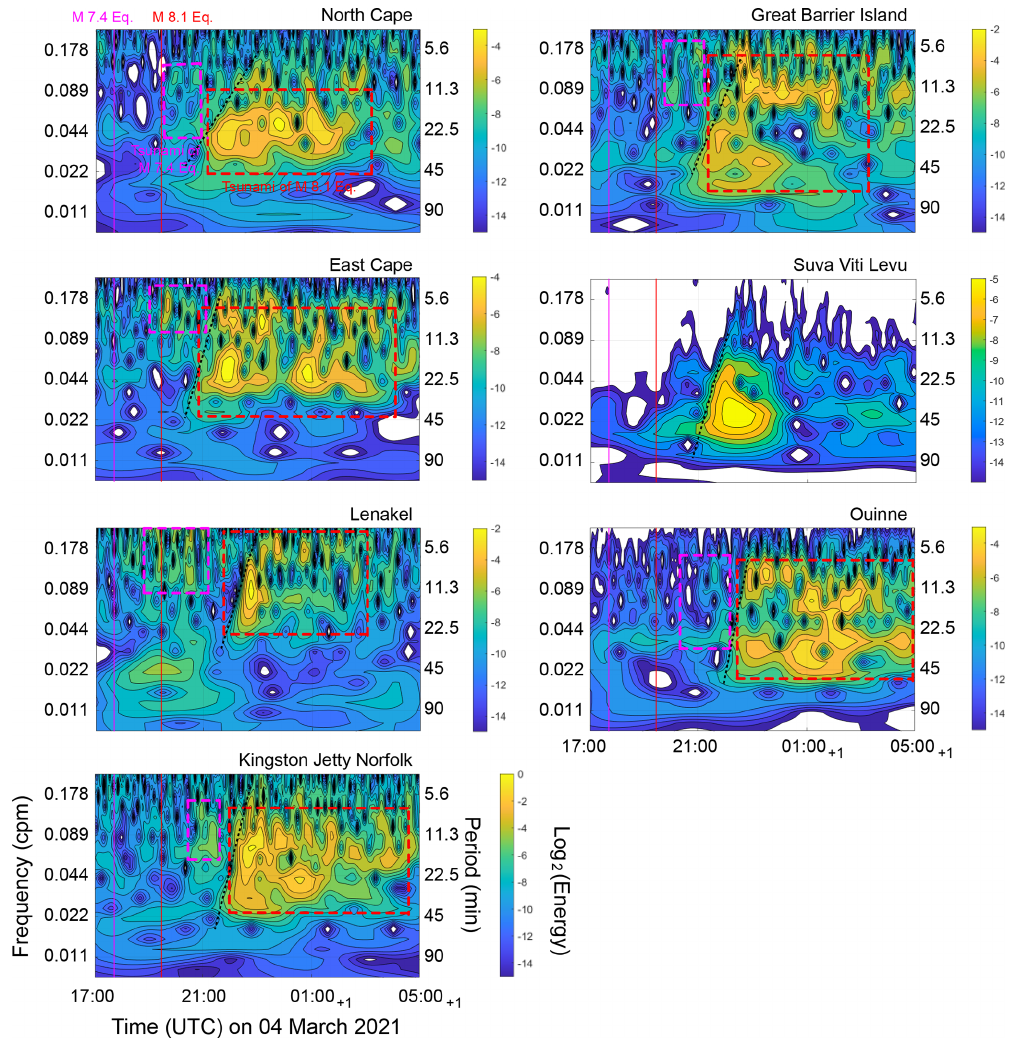
Figure 4. Wavelet (frequency–time) analyses for tsunamis generated by two successive earthquakes ( M w 7.4 and M w 8.1) in the Kermadec Islands. The colormap shows levels of spectral energy at different times and periods. For guidance, we marked the dominant periods of two tsunamis by pink ( M w 7.4) and red (M w 8.1) rectangles. The pink and red vertical lines show the origin times of the M w 7.4 and M w 8.1 earthquakes, respectively. The dispersion curves are plotted by black dashed lines. On the horizontal axis, plus one ( + 1) indicates one day